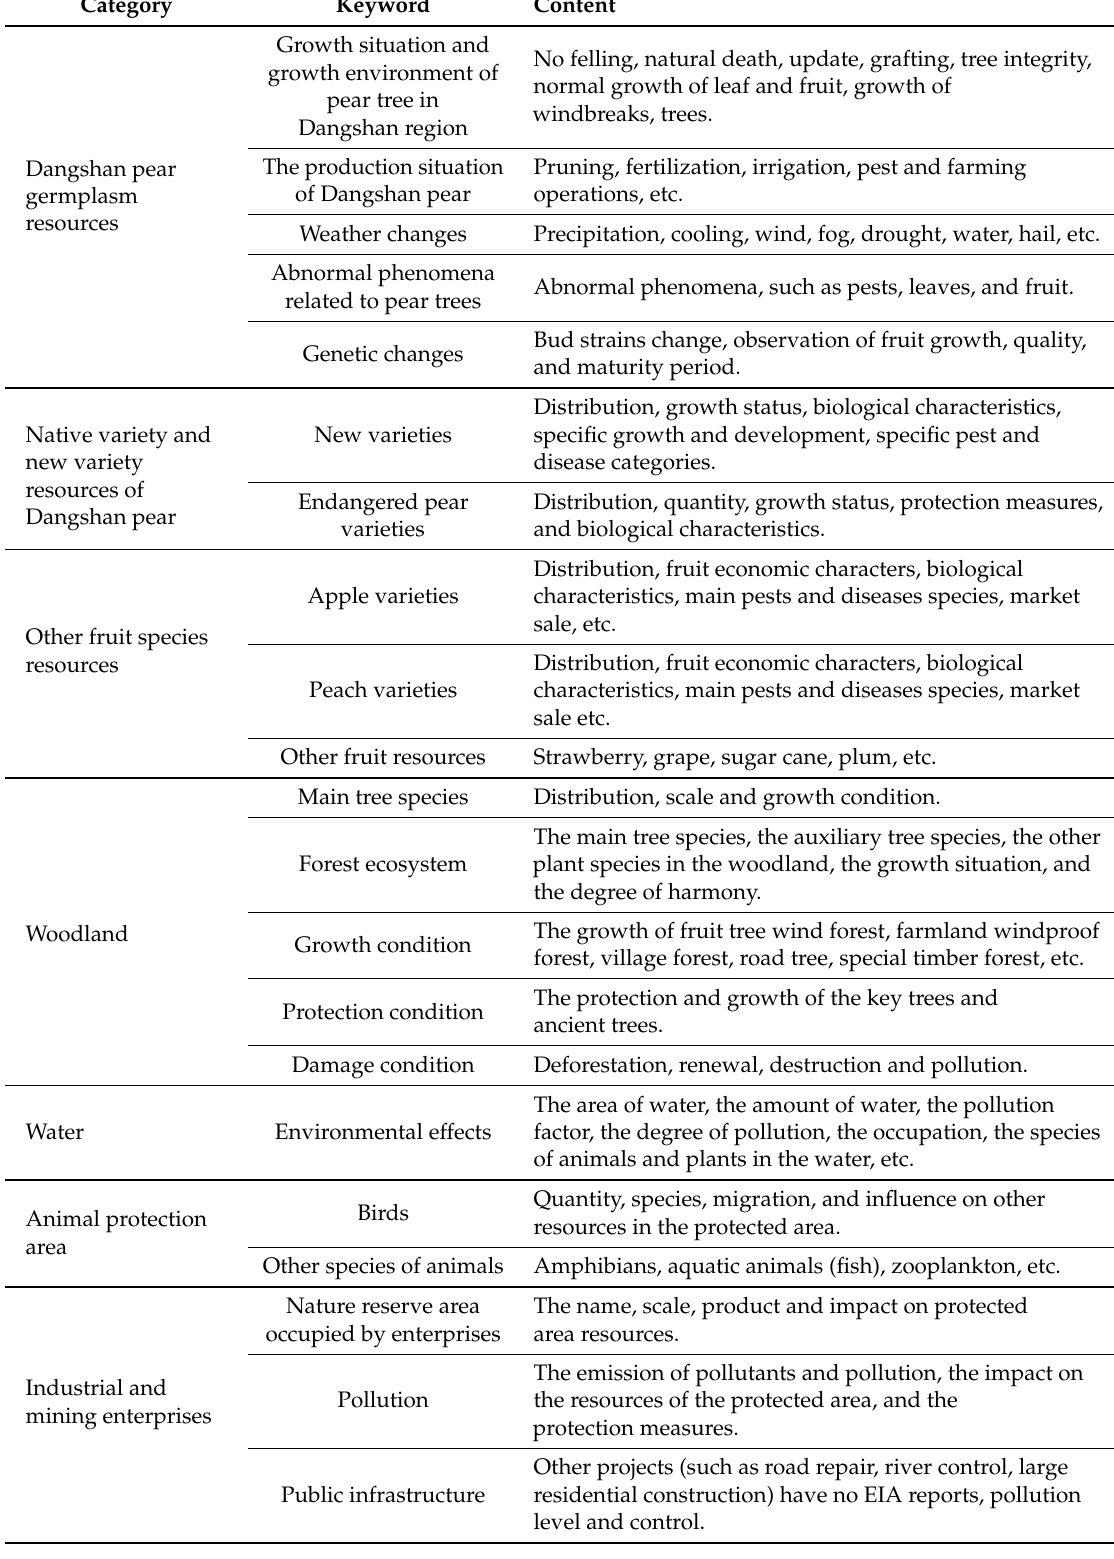
Table 1. Recommended project